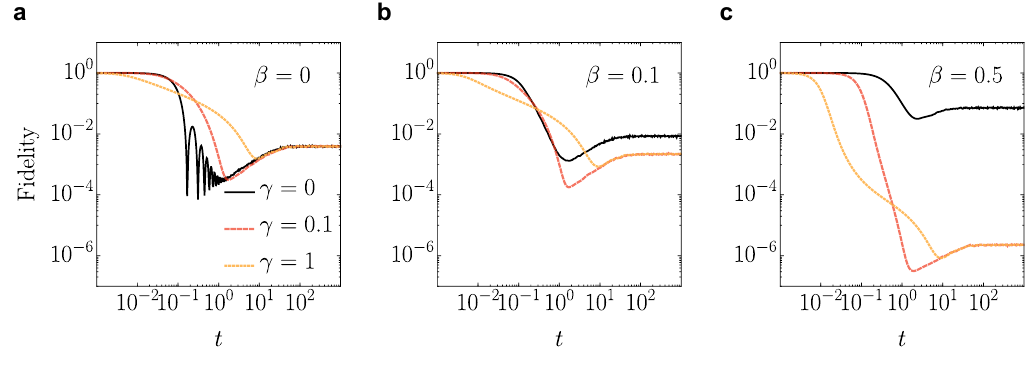
Figure 4 . The deformed SFF for BNGL in random matrix theory. The time-dependence of the fidelity between a coherent Gibbs state and its time evolution generalizes the notion of the SFF of Hermitian Hamiltonians to open quantum systems, including those governed by non-Hermitian Hamiltonians. Different panels correspond to different temperatures of the initial state. Each panel shows the evolution under BNGL for κ = 2 and different values of the dephasing strength. The average is taken over a sample of 1000 GOE(2 8 ) undeformed Hamiltonians H 0 . At infinite and high temperature, the nonunitary dynamics under BNGL preserves the main features of the SFF, displaying a decay, a dip, a ramp and a plateau. Deviations from the unitary case ( γ = 0 ), suppress quantum noise in the neighborhood of the dip as well as in the plateau. Increasing the dephasing strength γ alters the decay, delaying the appearance of the dip and shortening the ramp, while keeping the onset of the plateau unaltered. At lower temperatures (when the annealed approximation is expected to fail), BNGL prolongs the decay, enhancing the dip. As a result the ramp and the plateau take lower values than in the unitary